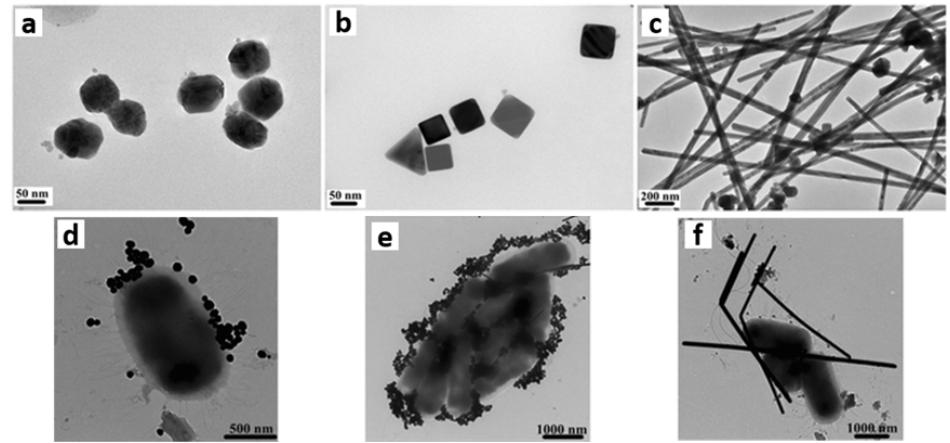
Figure 2. TEM images of silver nanoparticles ( a ); silver nano cubes ( b ) and silver nanowires ( c ) and their respective interaction with E. coli cells ( d – f ). [Reproduced from [34] with permission. Copyright (2016) Springer.].